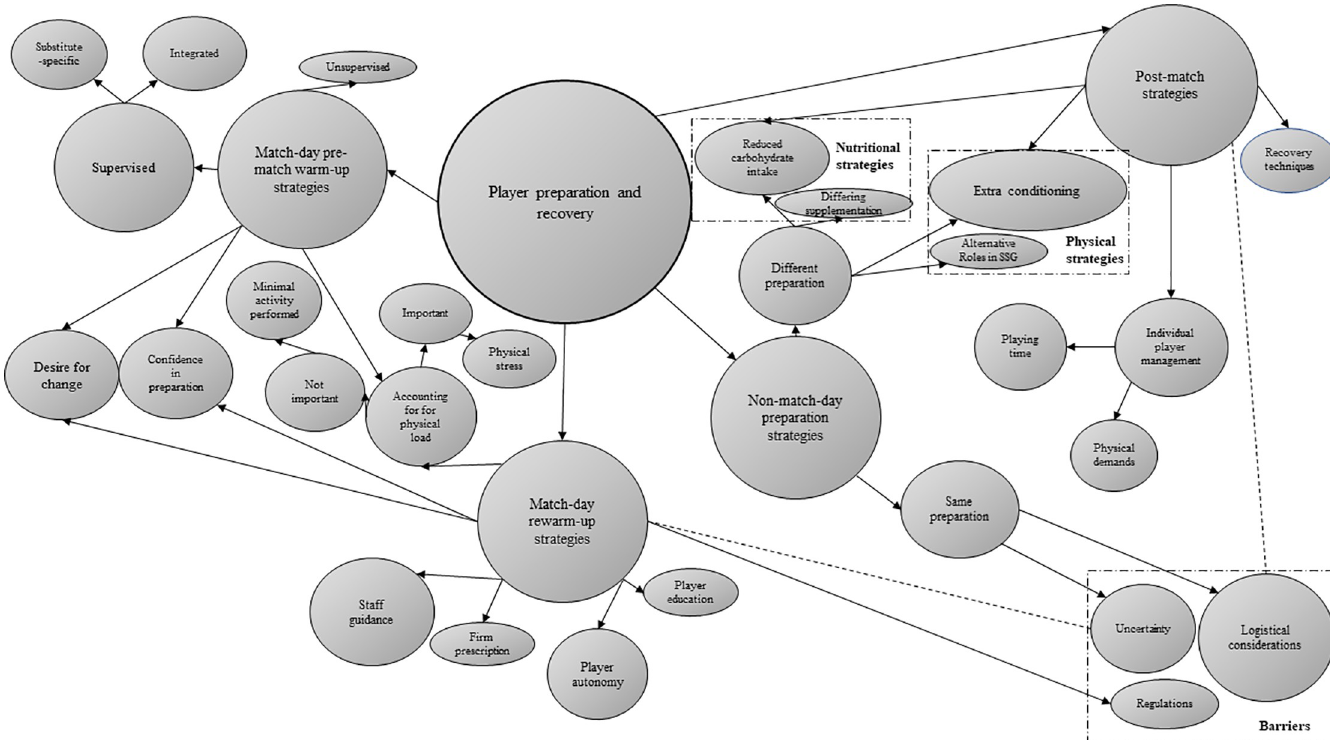
Fig 3. Thematic emergences depicting physical practitioner responses concerning player preparation and recovery (n = 26). Prevalence is indicated by